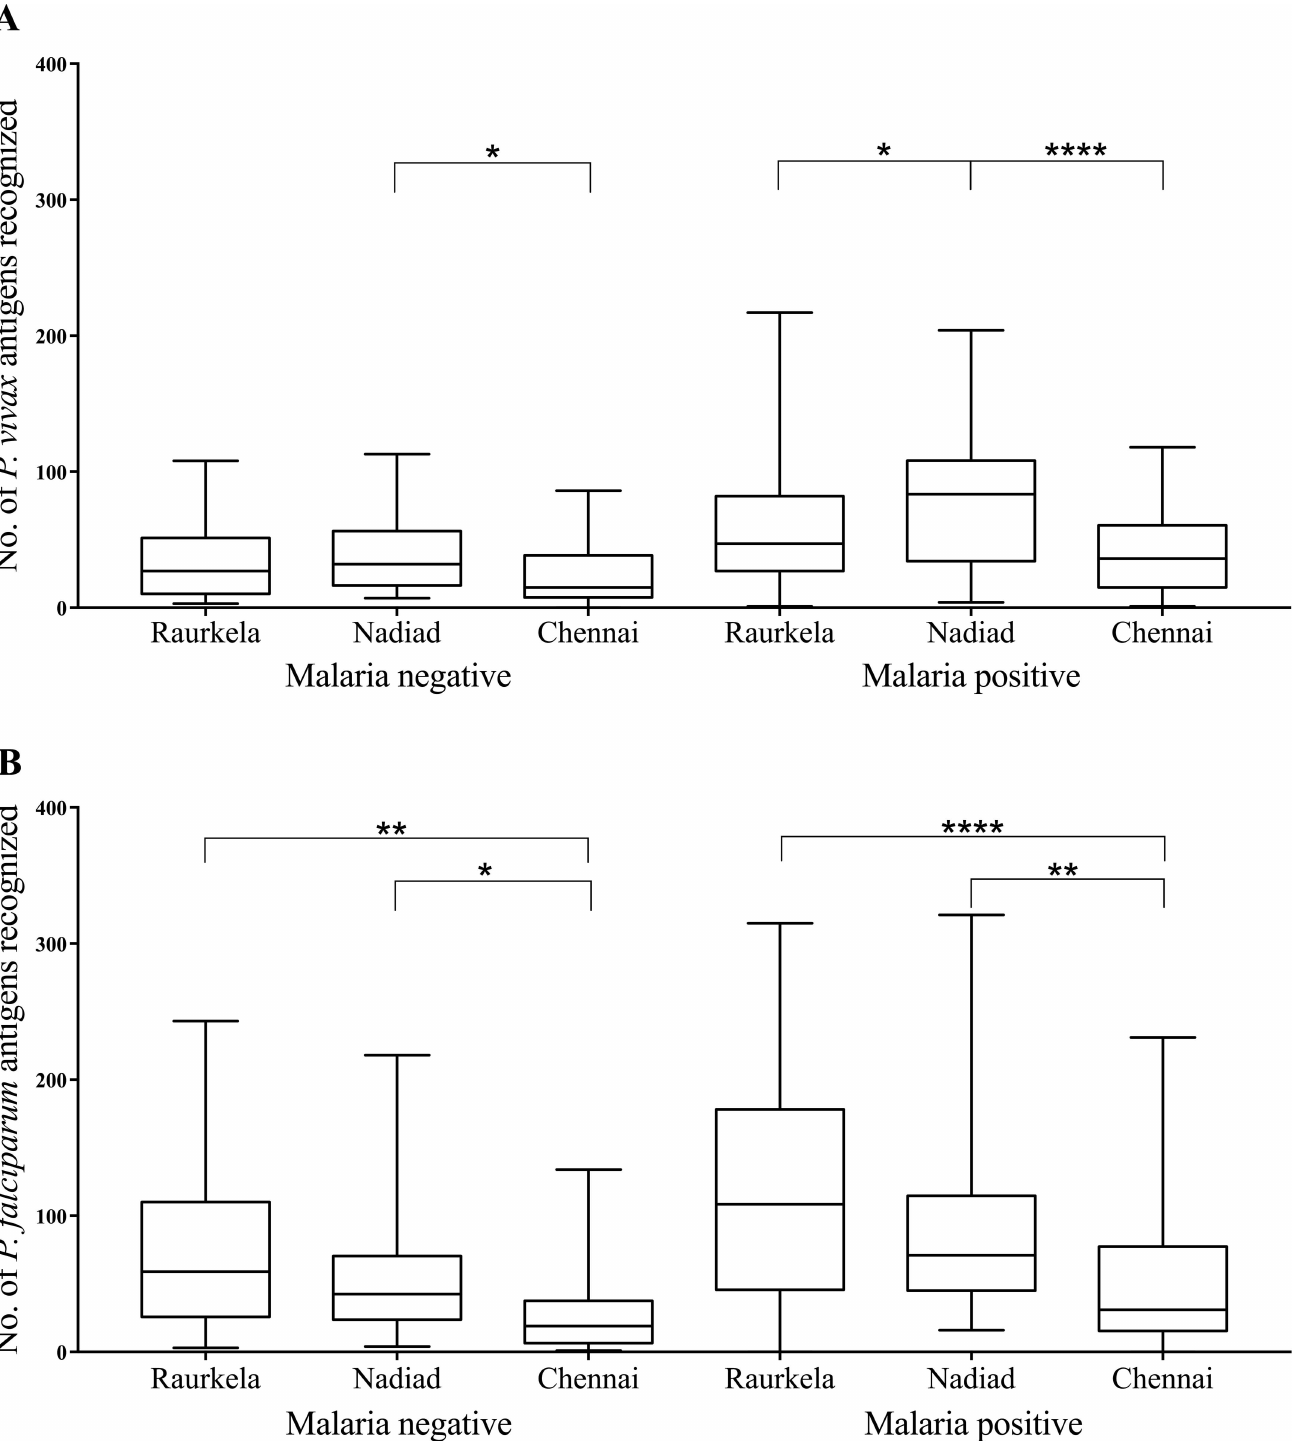
Fig 2. Breadth of antibody response to P . vivax and P . falciparum . Breadth of responseto A) 265 P . vivax and B) 373 P . falciparum antigens in samples collectedfrom malaria-positive (Chennai = 45; Nadiad= 55; Raurkela= 74) and malaria-negativeadults (Chennai= 25; Nadiad= 34; Raurkela= 32) at three sites in India. The box indicatesthe first and third quartiles, the line inside the box indicatesthe median,and whiskers represent the minimum and maximum values. Kruskal–Wallis/Dunnadjustedp-values for pairwisecomparisonof groups are shown as asterisks: 0.03 ( * ), 0.002 ( ** ), 0.0002( *** ), < 0.0001( **** ).